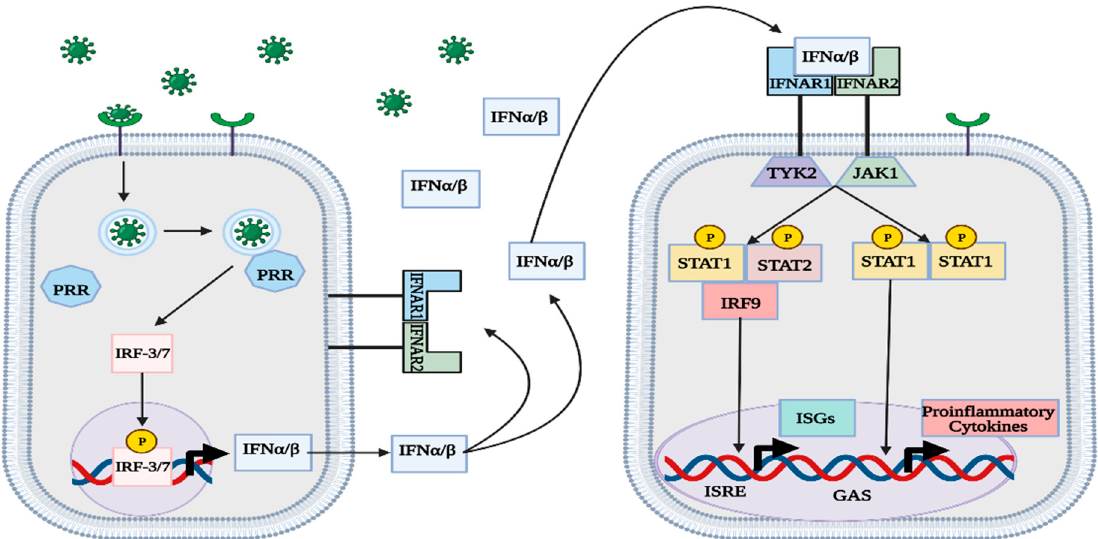
Figure 2. Overview of canonical type-I IFN pathway. PRRs within infected cells recognize the virus and induce IFN α / β production. The type-I IFNs are secreted and act on IFN α receptors, which facilitate the transcription of ISGs and proinflammatory cytokines. The generation of ISG proteins in uninfected cells confers greater protection against the virus. This figure was created with BioRender.com (accessed on 20 January 2023).